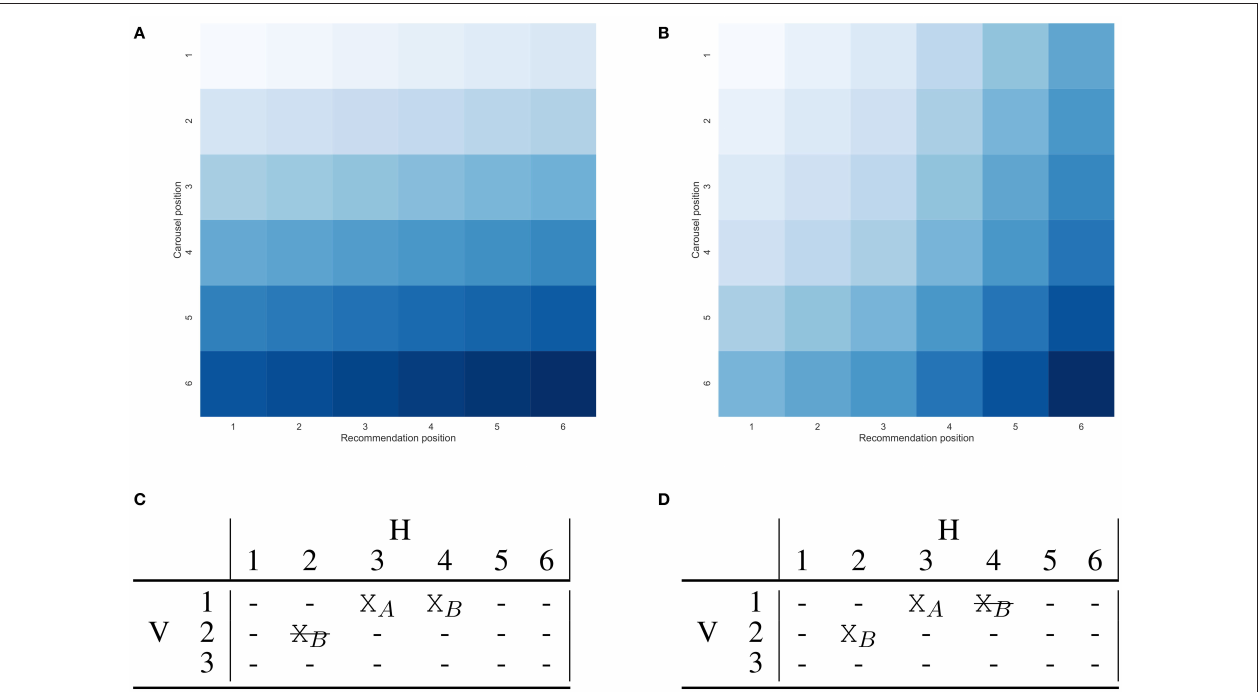
FIGURE 4 | A visual comparison of the two-dimensional discount function under different assumptions: (A) Represents carousels concatenated in a single list. (B) Represents two-dimensional discount which accounts for the golden triangle and number of user actions. (C,D) Show the impact of the discount function on the relevance of a correct recommendation. Consider a small user interface with 3 carousels, each with 6 elements. Correct recommendations are represented with “ X n " with n the item identifier, while incorrect ones by “-". Item B is recommended correctly both by the first and second recommendation list. Only one of the two will be considered relevant, depending on the discount, the other is shown as crossed out. The single list discount shown in (A) will lead to consider relevant the recommendation of item B in the first carousel, while the two-dimensional discount shown in (B) will lead to consider relevant the recommendation in the second